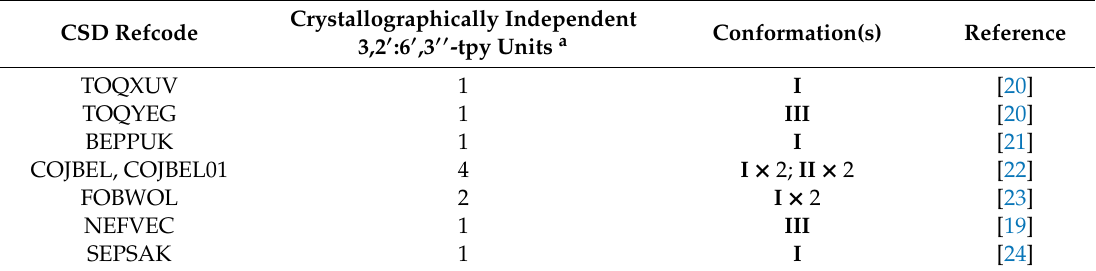
Table 1. Conformations of previously reported free 3,2′:6′,3′′-tpy ligand structures. Crystallographically CSD Refcode